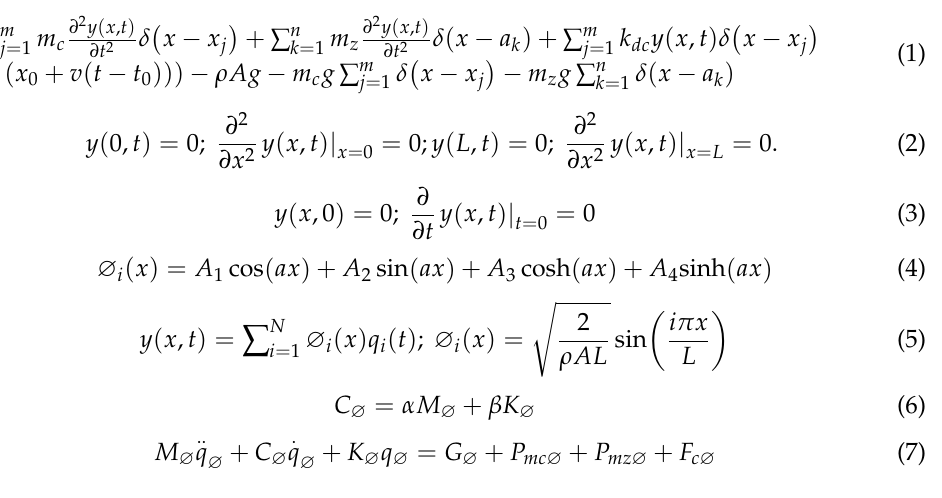
Table 1. Definition of parameters of the rigid catenary